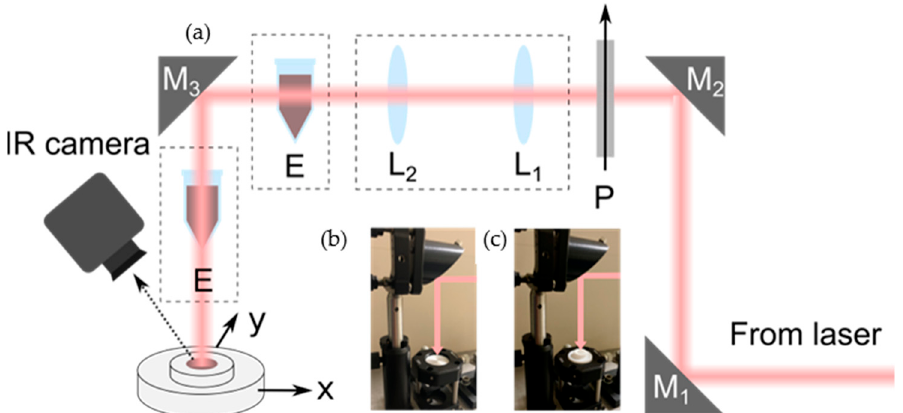
Figure 2. ( a ) Optical set-up for the heating measurements. ( b ) The x-y mount with the alignment iris. ( c ) The x-y mount with the Teflon vessel on top. P: Polarizer; L1, L2: Lenses; E: Eppendorf tubes. The boxes in dashed lines indicate that the elements are set in the light path when required.